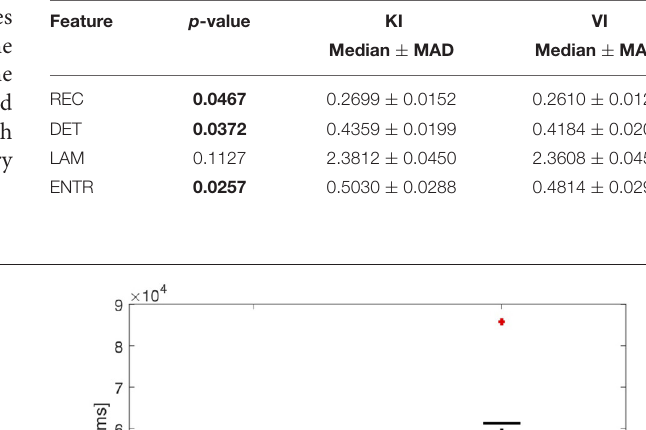
TABLE 2 | Statistical comparison between kinaesthetic task (KI) and visual tasks (VI).